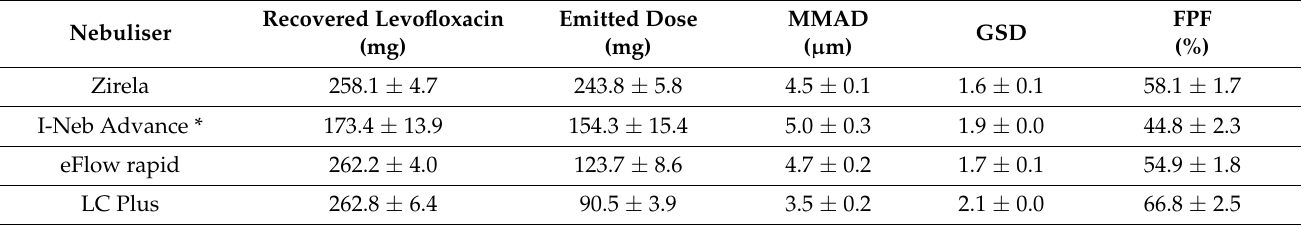
Figure 2. Next-Generation Impactor (NGI) stage (S) deposition of levofloxacin with each nebuliser. The inset shows the cumulative levofloxacin percentage below the size cut-off of each NGI stage. MOC, micro-orifice filter. Table 1. Emitted dose and aerosol particle size distribution parameters for each nebuliser.